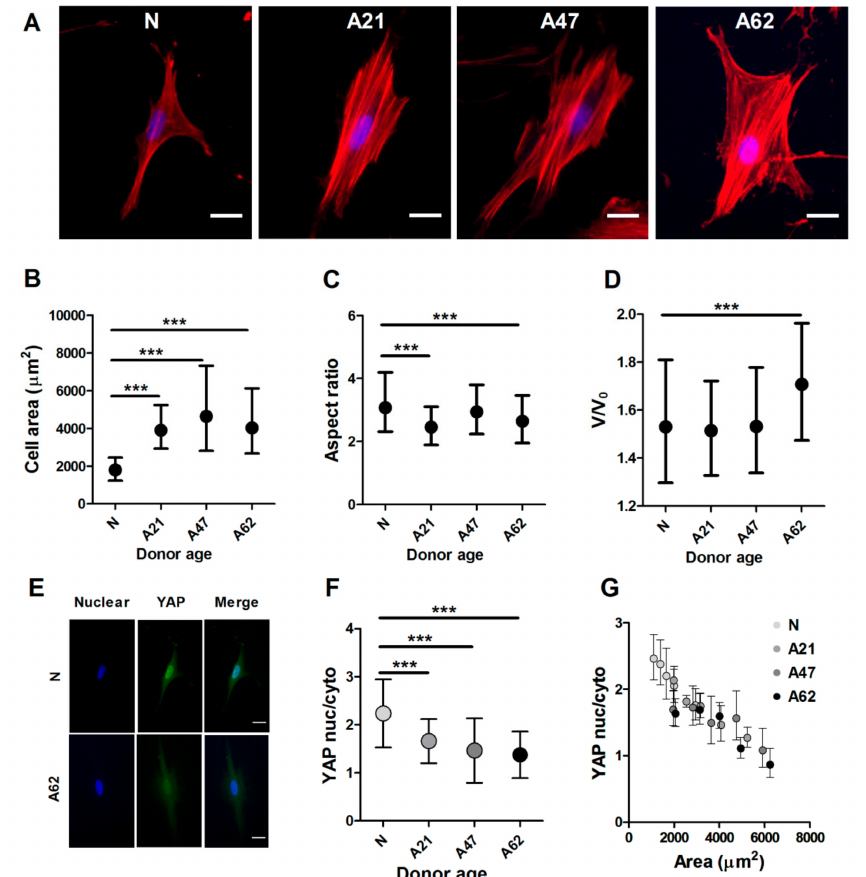
Figure 2. Cellsfromageddonorsexhibitedchangesincellularandnuclearmorphology. ( A )Represantative epifluorescence images showing increased cell area and F-actin organization of cells from donors